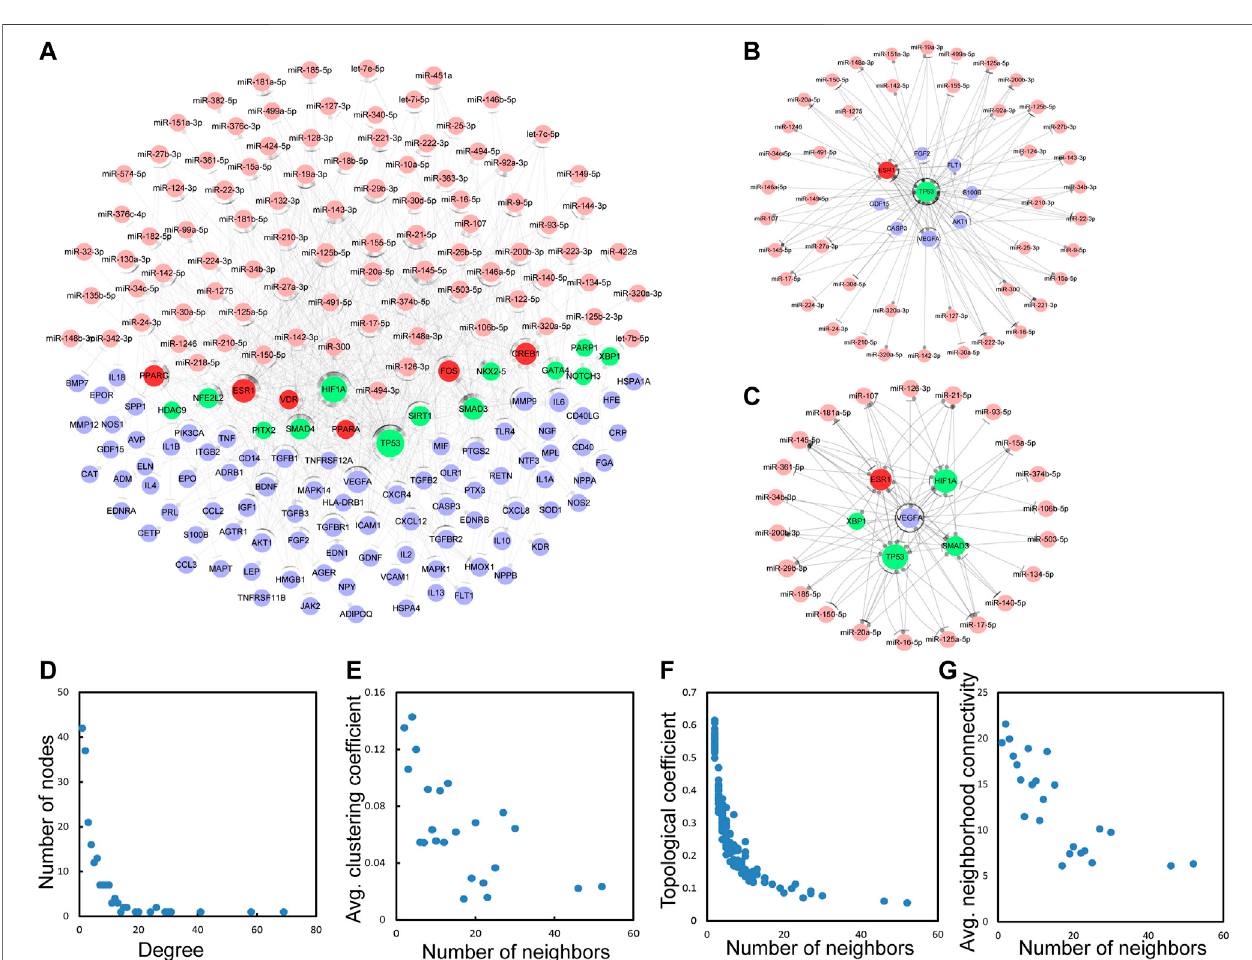
FIGURE3 | The basic characteristics of thenetworkwith four types ofregulatory pairs (miRNA-gene, miRNA-TF,TF-miRNA, TF-gene). (A) Aglobal ofthe network with four regulatory pairs. TFs, miRNAs, immune genes and TF&immune genes are colored green, pink, blue and red, respectively. (B) A sub-network with TP53 as the central node. (C) Asub-network with VEGFA as the central node. (D – G) The basic features of the network include degrees, clustering coef fi cient, topological coef fi cient and neighborhood connectivity of the network.